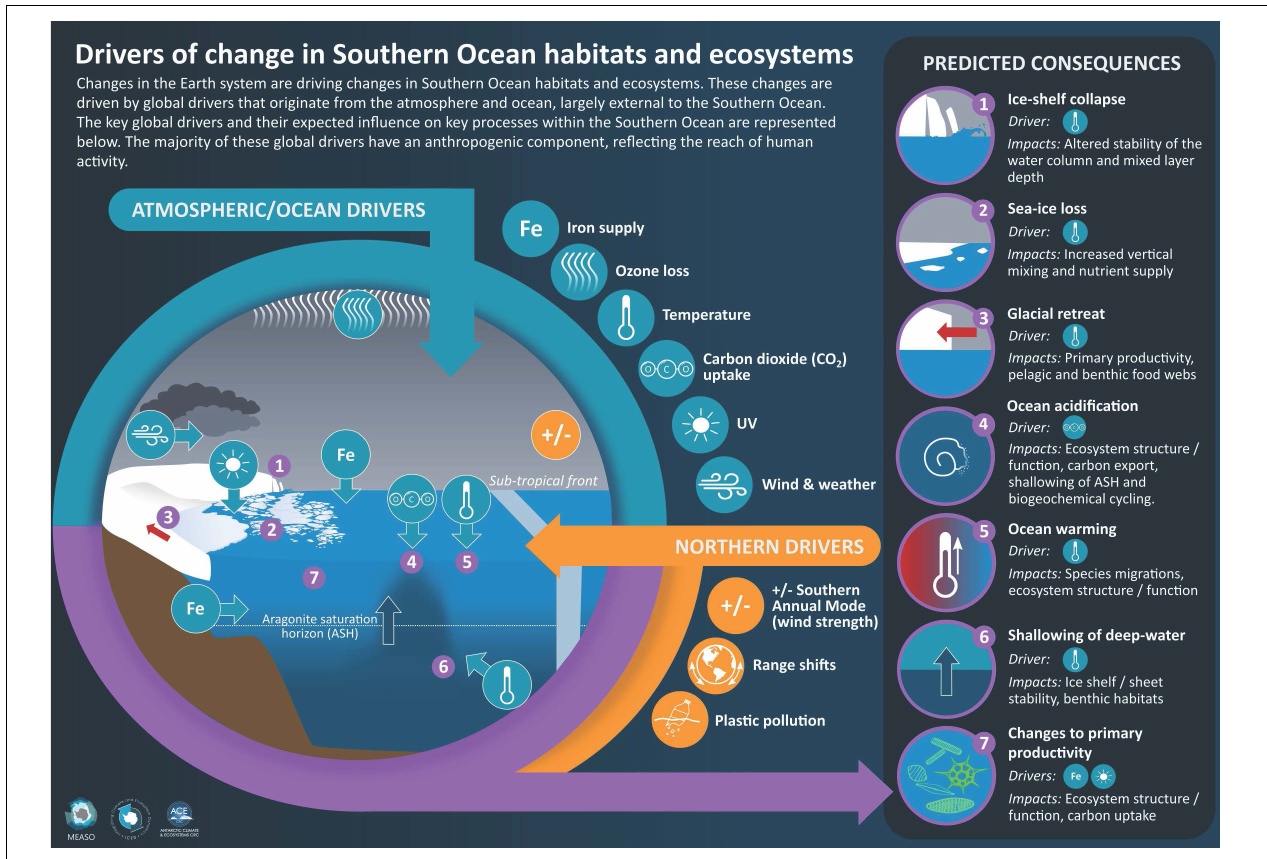
FIGURE 1 | Description of the global drivers affecting the Southern Ocean. Northern drivers are global drivers whose influence reaches from North of the Southern